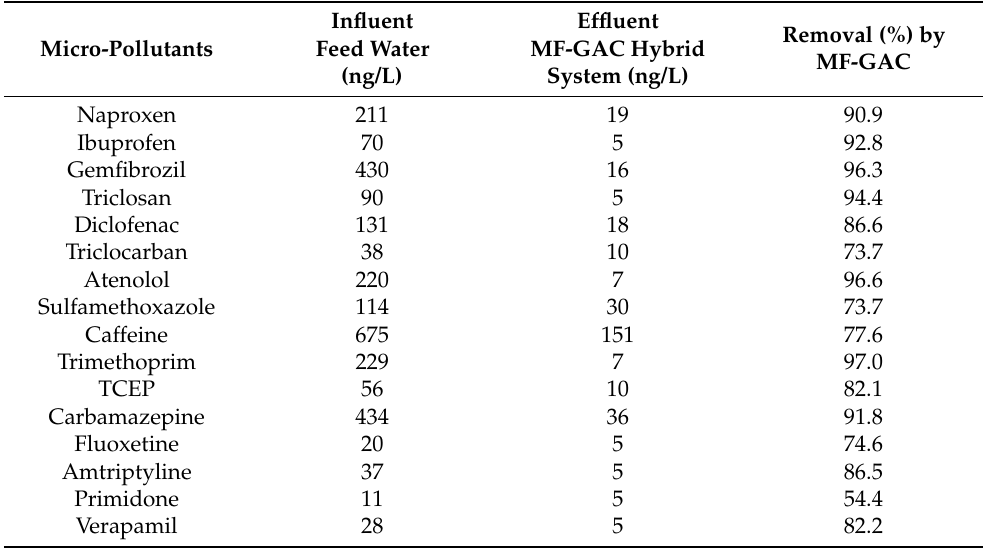
Table 3. Removal (%) of micro-pollutants by MF-GAC hybrid system (GAC’s initial dosage of 2